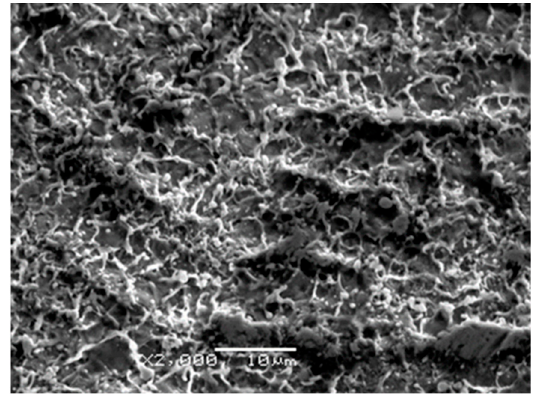
Figure 7. SEM image taken on a segment of a track ablated by 10,000 pulses focused onto 0.085 mm 2 area on the target surface.